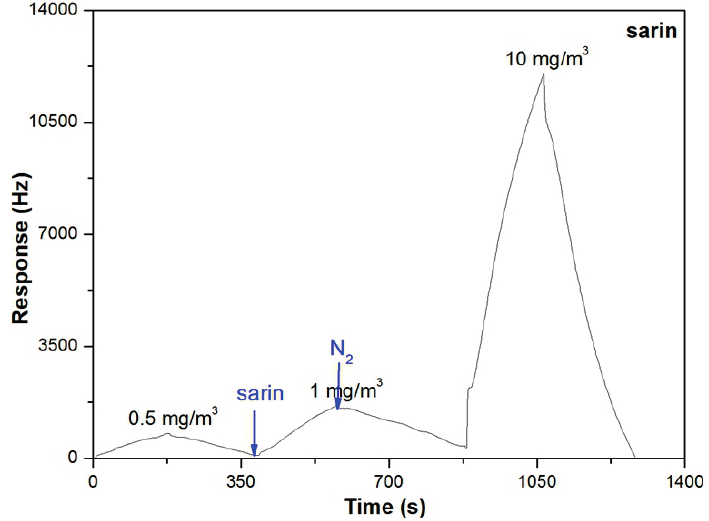
Figure 3. Real-time responses of the sensor to sarin at the concentrations of 0.5, 1 and 10 mg/m 3 (3 min sarin and 3 min N 2 ).